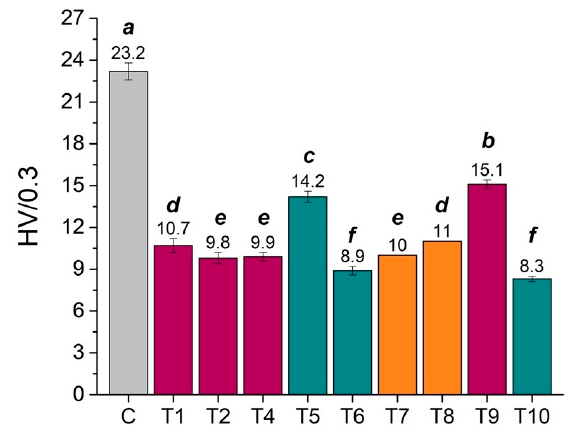
Figure 6. Vickers hardness values (average and standard deviations) for a control, unexposed sam- ple (gray bar labeled C) and CO 2 -exposed samples (colored bars T1–T10) at different conditions (supercritical: purple bars; liquid: blue bars; vapor: orange bars), measured approximately 4 h after tests. Statistical significance for ANOVA and Tukey–Kramer multiple comparison tests was estab- lished at a p -value < 0.05; mean values that do not share a superscribed letter are significantly dif- ferent.